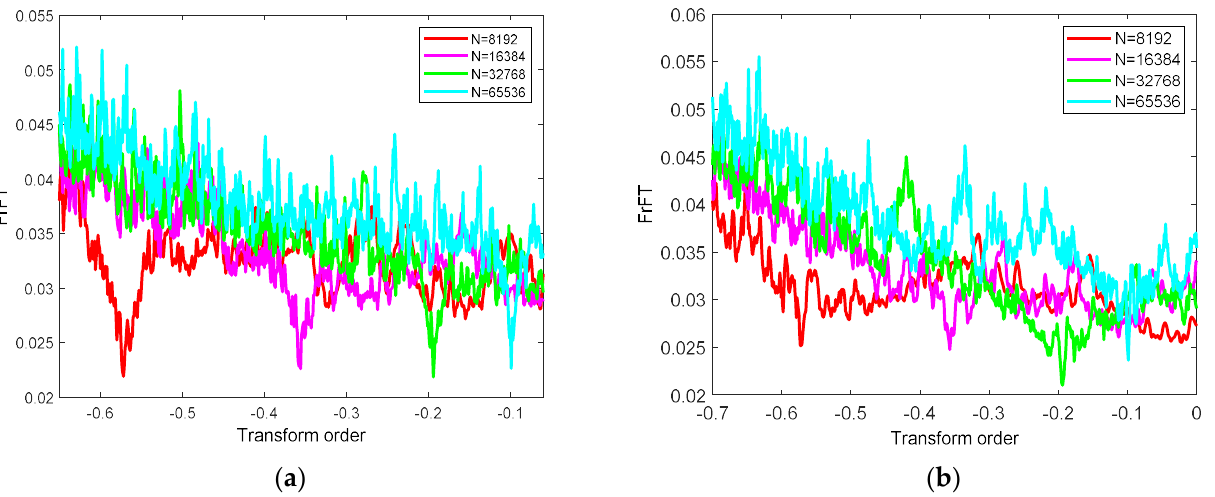
Figure 7. EC distribution of ( a ) PM-QPSK and ( b ) PM-16QAM signals under different sampling points.